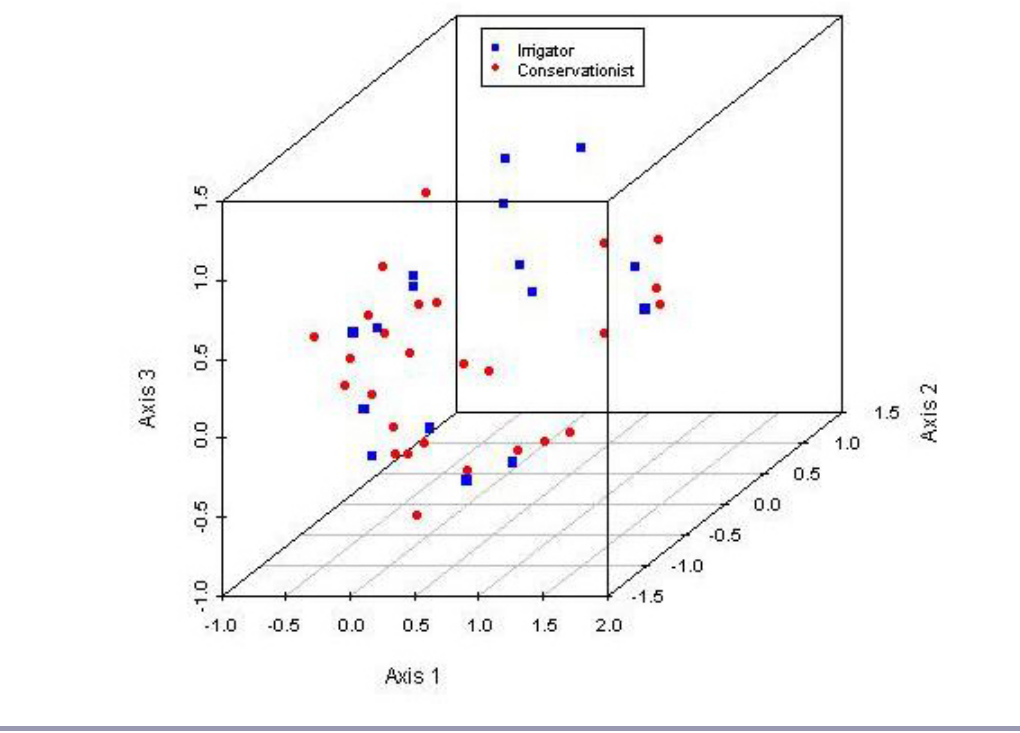
Fig. 3 . A three-dimensional nonmetric MDS map of similarities among respondents, with respect to their identification of major users of the Crocodile River catchment (stress =